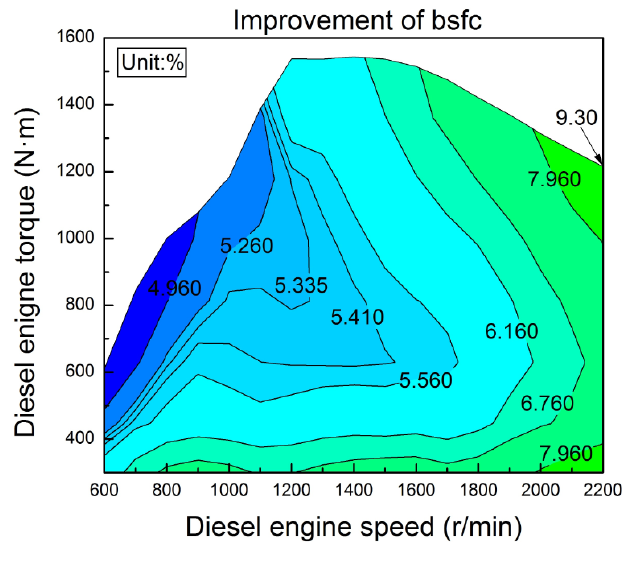
Figure 15. IRBSFC under engine various operating